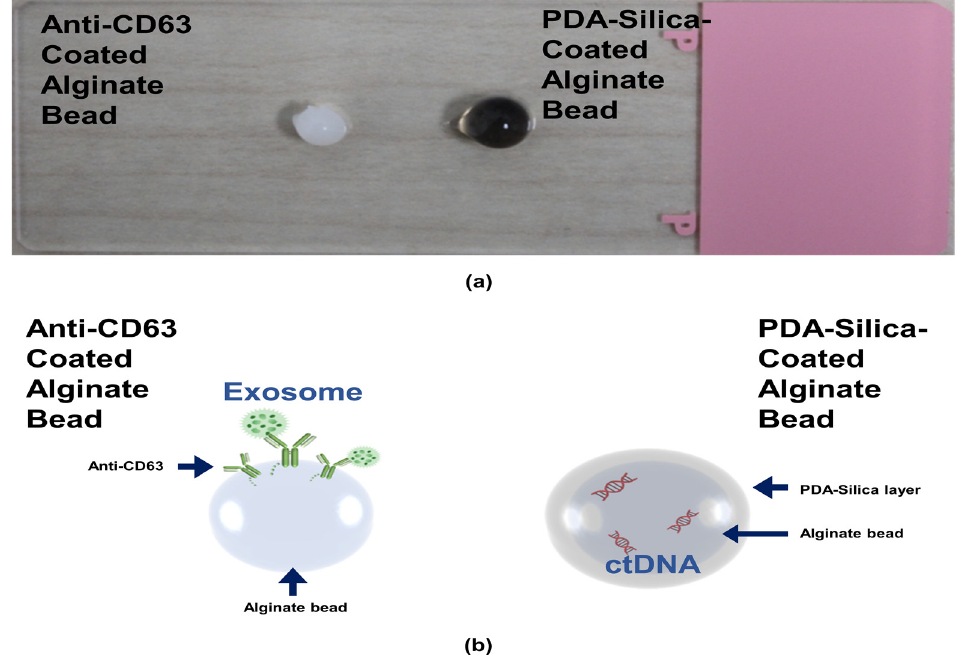
Figure 1. ctDNA isolated by a PDA–silica-coated alginate bead and an anti-CD63 immobilized alginate bead. ( a ) PDA–silica-coated alginate bead and anti-CD63 immobilized alginate bead, having a diameter of ~4 mm. ( b ) A schematic diagram illustrating applications of our isolation platform for ctDNA and exosome. It was used as a reliable platform for the diagnosis of CRC.